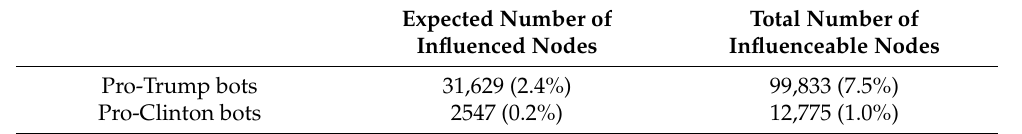
Table 6. Obtained results after 20 simulations of the diffusion process.